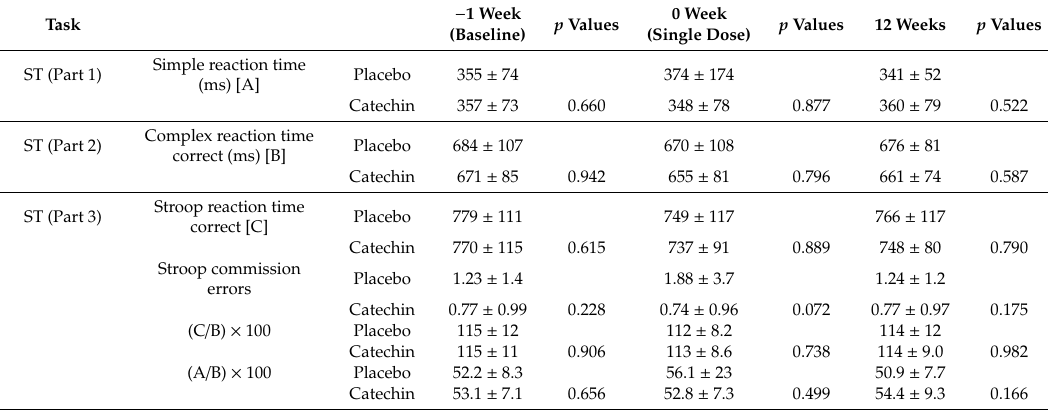
Table 3. E ff ects of green tea catechins on attention-related